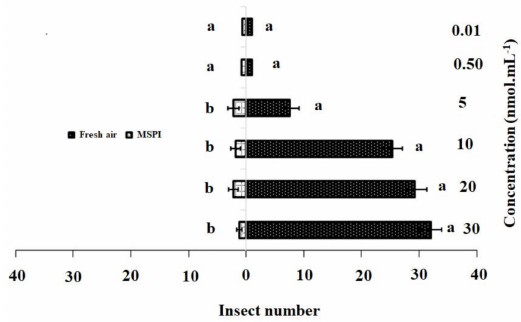
Figure 2. Responses of P. xylostella adult females to synthetic 3-methylsulfinylpropyl isothiocyanate (MSPI) compared with control. Bars represent the mean ( ± SE) response of adult female exposed to synthetic active volatile from Barbarea vulgaris plants. Di ff erent letters indicate di ff erences between two treatments at p < 0.05.